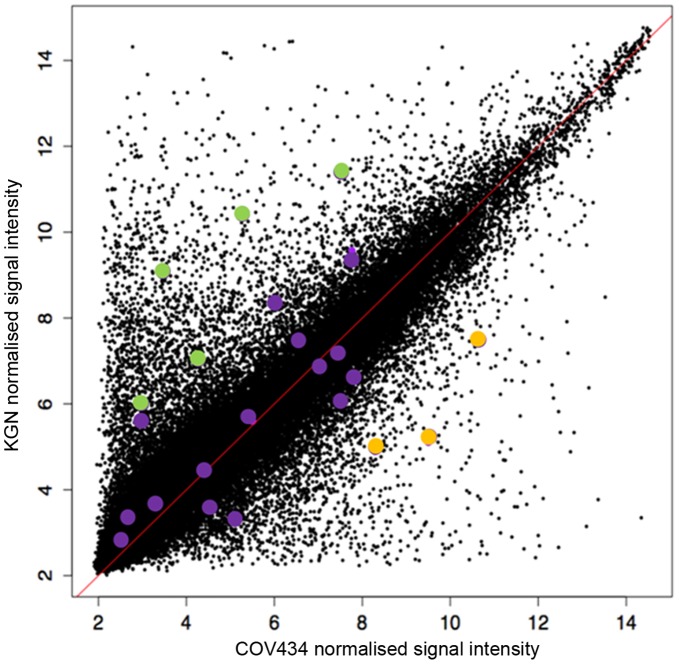
Cell line specific expression of FOXL2 targets.Each point represents a single probeset. Signal intensities have been calculated for each probeset by averaging the signal intensities from the three control samples from the COV434 and KGN array data. Coloured points (purple, green and yellow) represent FOXL2 targets described by Batista et al (2007). Although most genes appear to have similar expression in both cell lines, some genes appear to have preferential expression for either cell line. FOXL2 target genes that are more abundant in KGN include SOX9, SOX4, CYP19A, StAR and FST (as shown by green points). FOXL2 target genes that are more abundant in COV434 include NR5A2, NR4A3 and CDKN2A (as shown by yellow points).